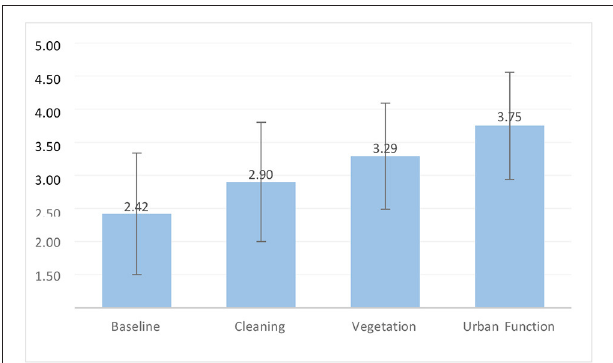
FIGURE 6 | Average perceived safety of the baseline and three categories of interventions ranging from low to high scores. A rating greater than 3.00 is a positive perception and lower than 3.00 is a negative perception. Error bars represent ± 1 standard deviation.